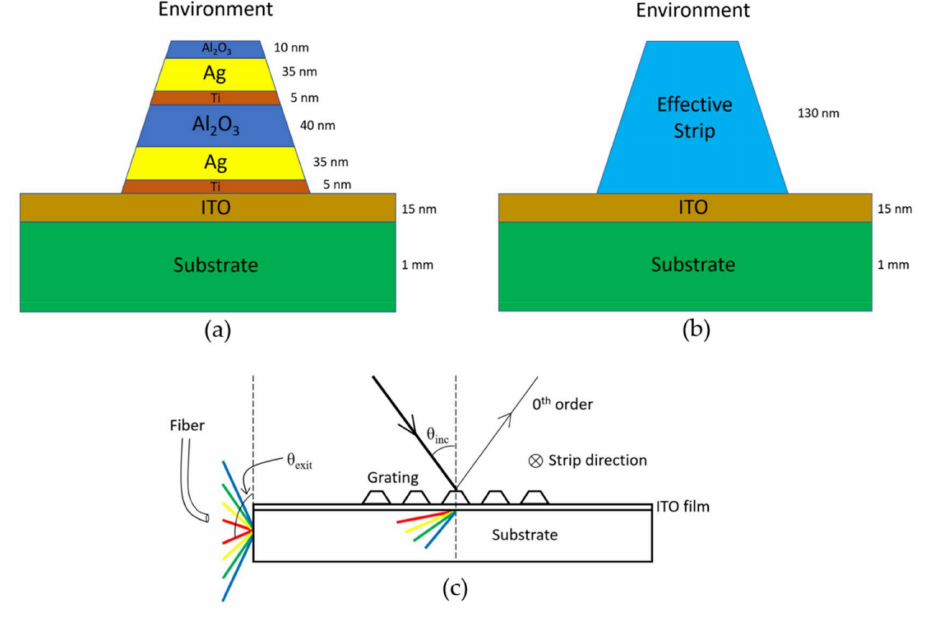
Figure 1. Sample geometry and experimental setup. Panel ( a ) shows the vertical substructure of the strip; ( b ) portrays the replacement of the real structure with an effective strip; ( c ) depicts the inclined illumination setup, in addition to usual far-field transmission spectroscopy, necessary for retrieving the optical